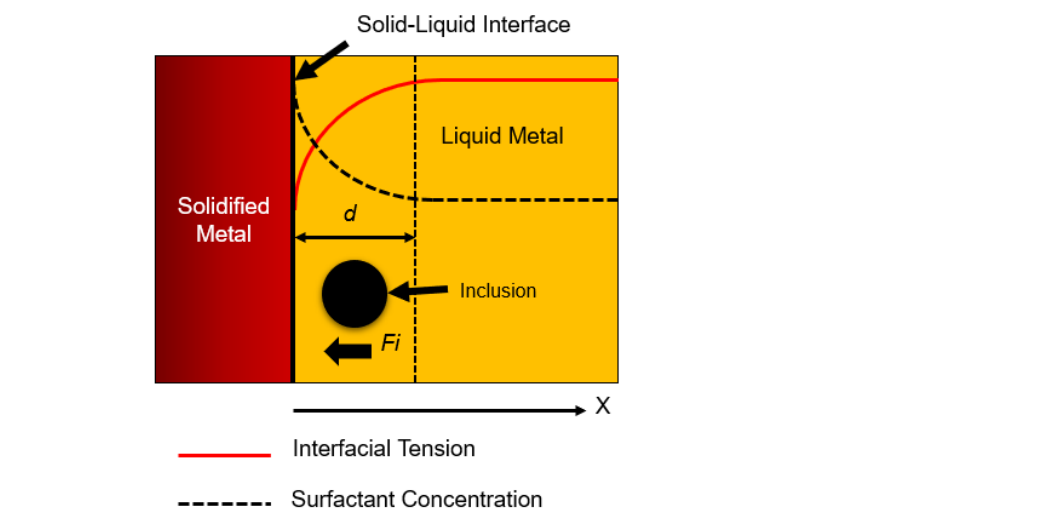
Figure 3. Interfacial tension and surfactant concentration on inclusion near the solid–liquid inter- face.